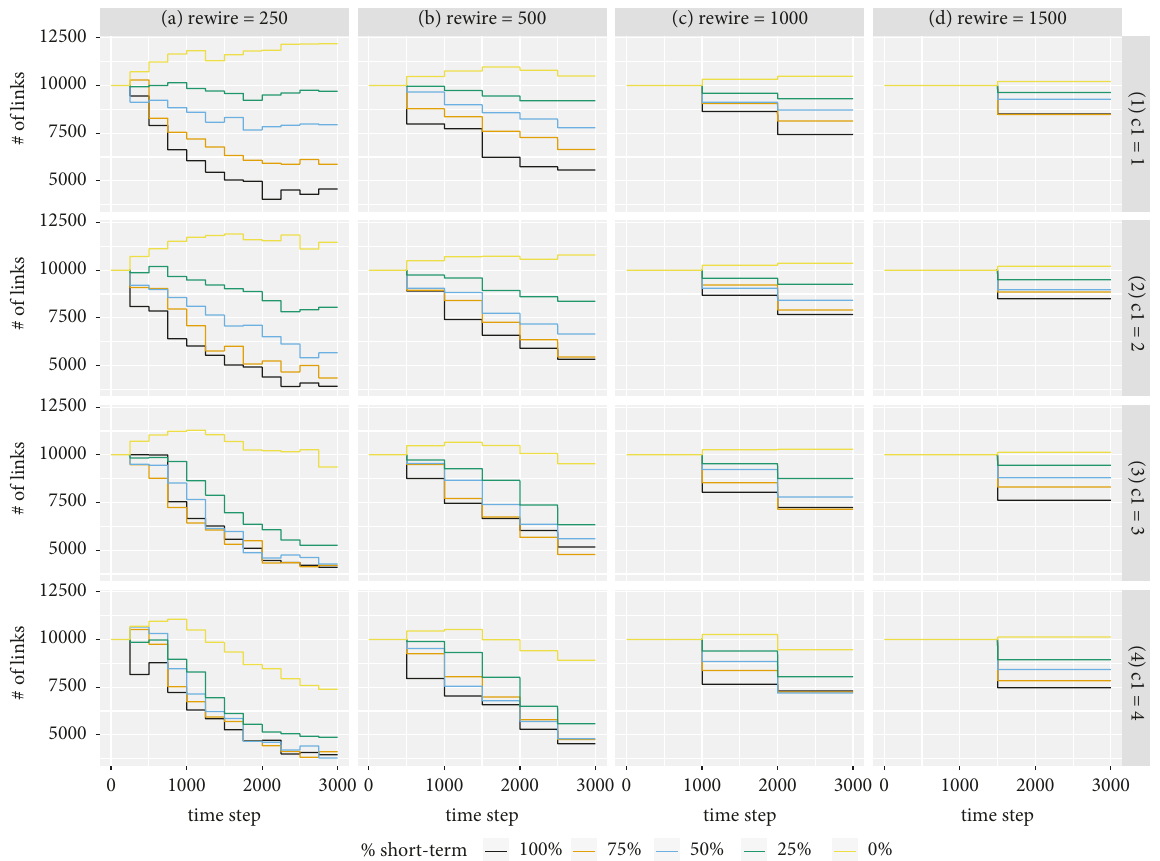
Figure 7: Temporal evolution of the variation in the median number of links maintained in the network after rewiring. Rewiring occurs at discrete steps; hence, the “jagged” appearance in the evolution of the metric. A higher frequency of rewiring is responsible for impairing the